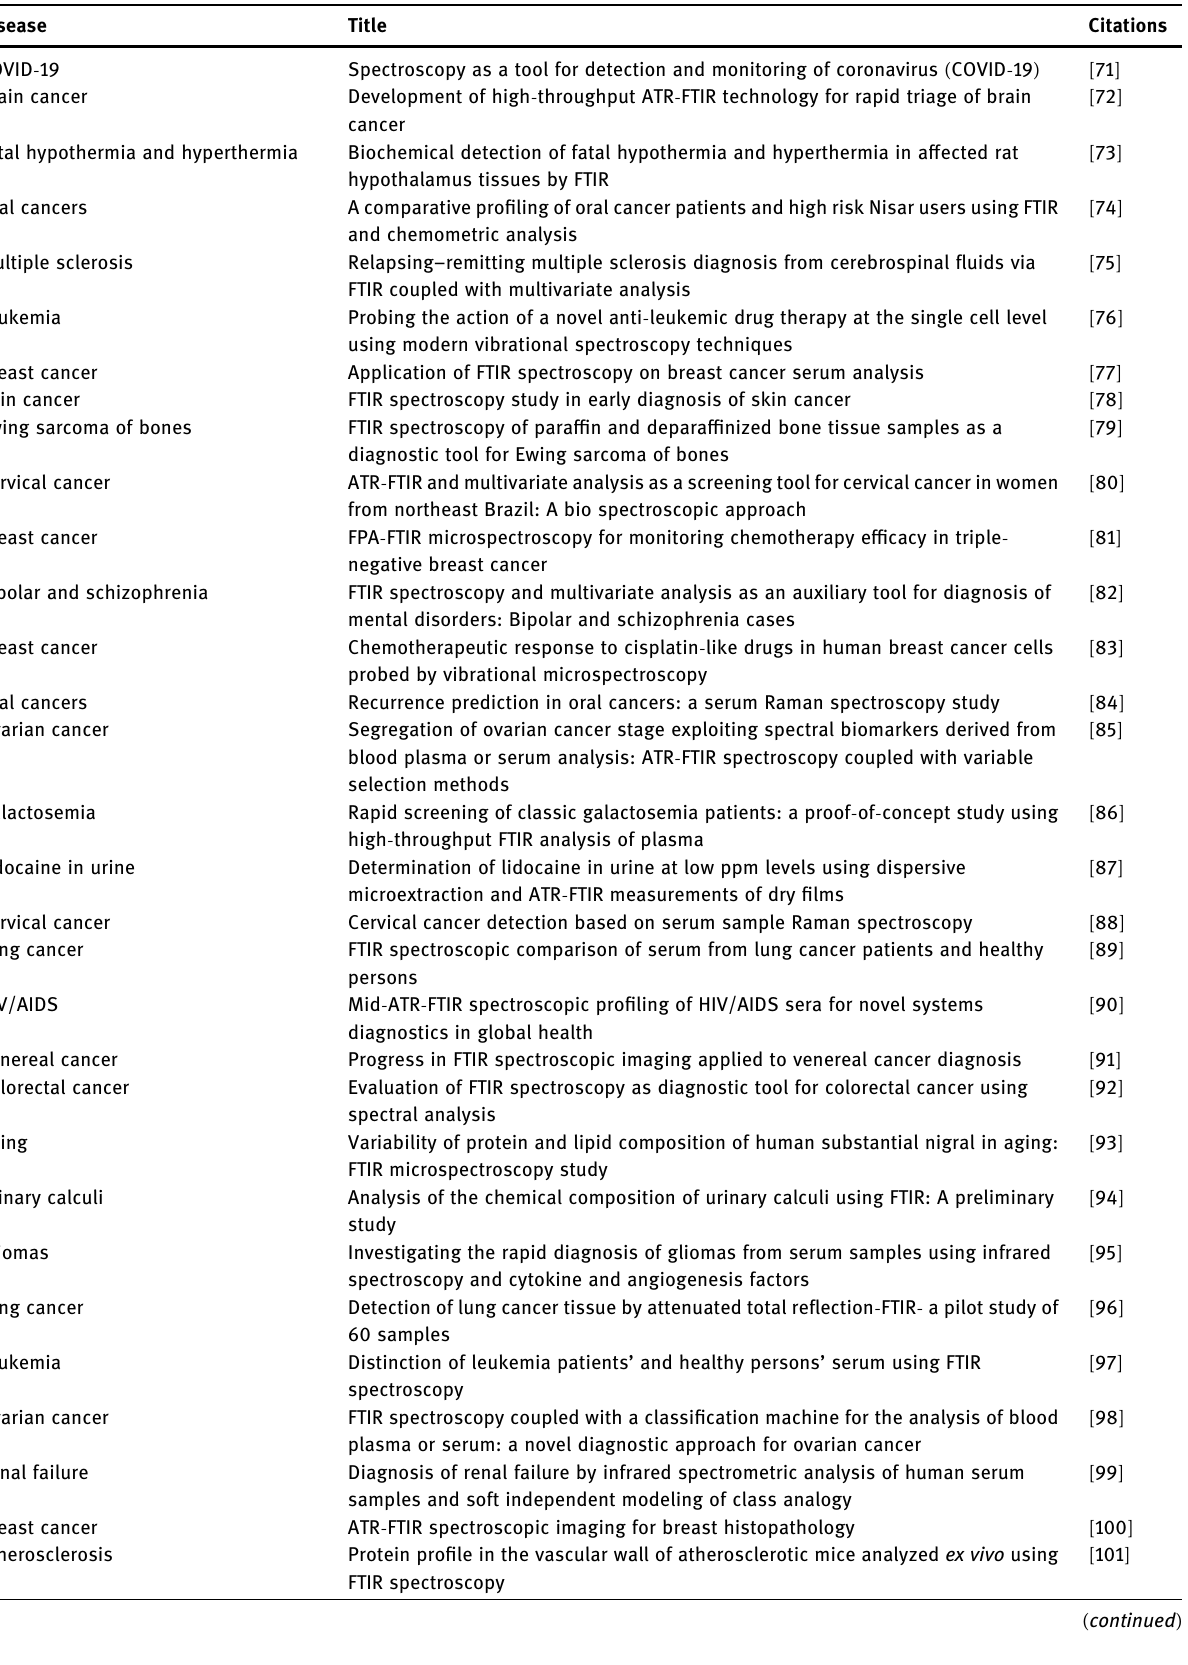
Table 5: Selected publications on using FTIR spectroscopy for early diagnosis of diseases